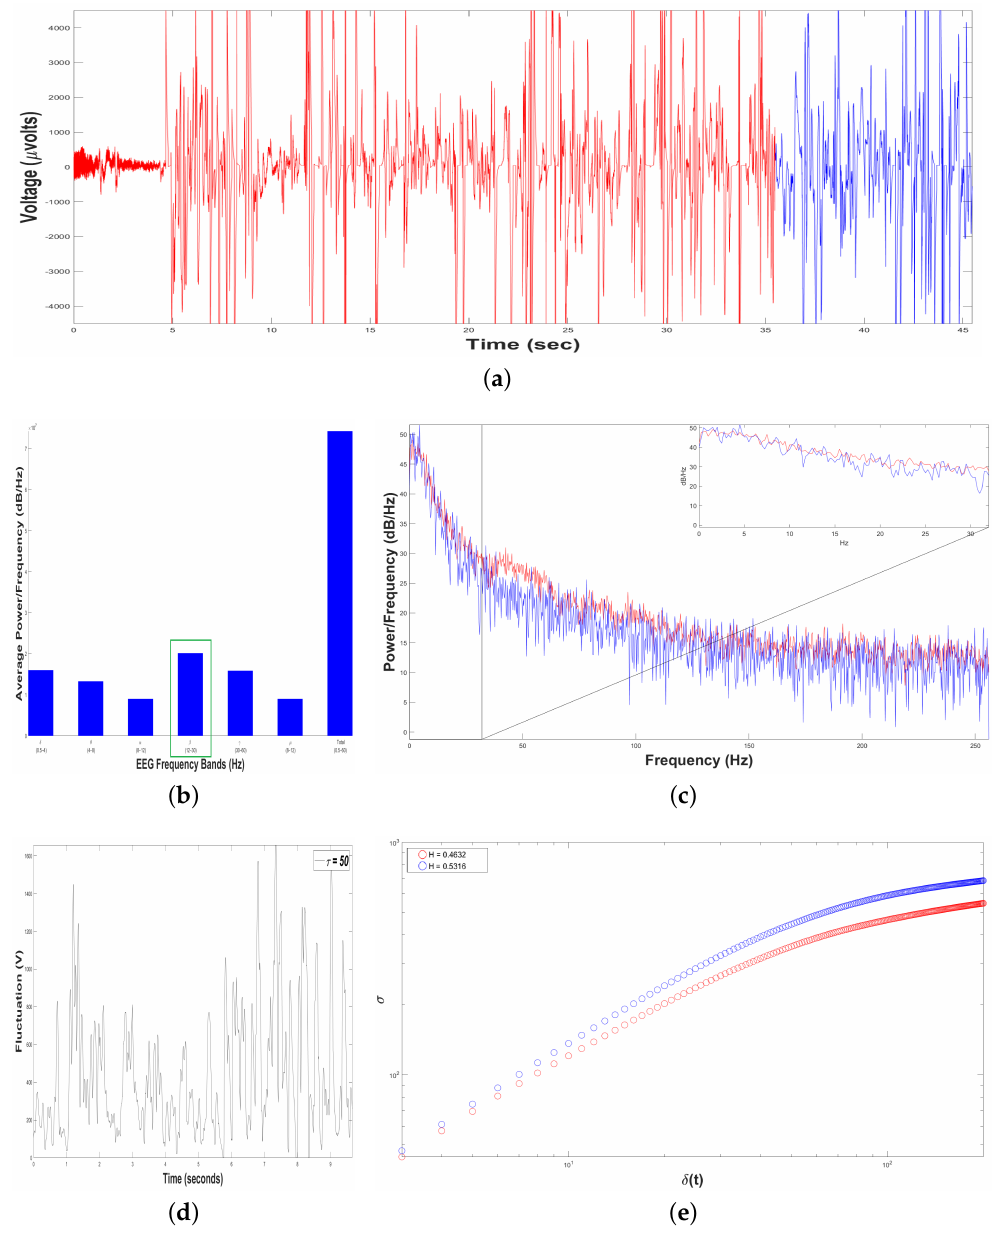
Figure 7. Results of Dolphin EEG brain activity for Intervention Patient 1. ( a ) Representation of the RAW data x ( t ) ( µ V vs. sec) for Sample 1 (in red color) and Sample 2 (in blue color). ( b ) Average Power Spectrum Density. ( c ) Power Spectrum Density from 0.5 to 256 Hz, for Sample 1 (in red color) and Sample 2 (in blue color). ( d ) Time series of fluctuation of Dolphin EEG brain activity, F ( t + τ ) for τ = 50. ( e ) Structure function of fluctuations of Dolphin EEG brain activity, ( σ ( τ , δ t ) vs. δ t ) for 3 ≤ τ ≤ 200, for Sample 1 (in red color) and Sample 2 (in blue